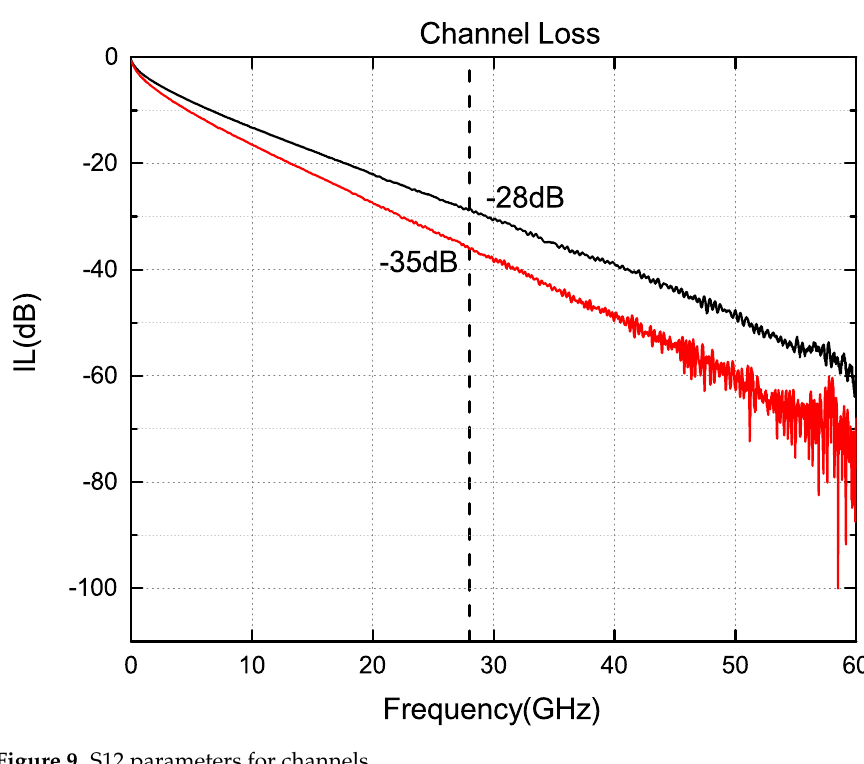
Figure 9. S12 parameters for channels.